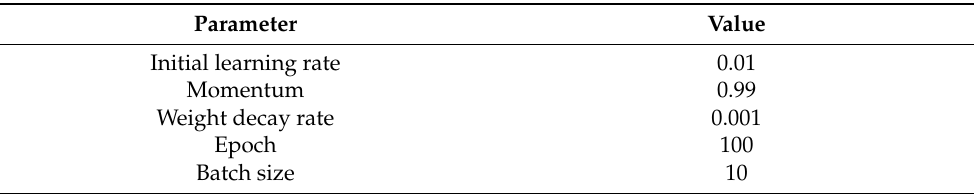
Table 2. Training parameter settings.